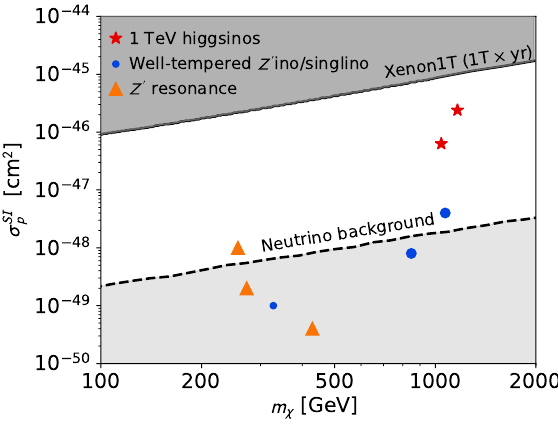
Figure 6. The position of the benchmark points in the ( m (cid:31) , (cid:27) SI 90% C.L. upper bound from the XENON-1T Collaboration [59]. Di(cid:11)erent point-styles mark the di(cid:11)erent types of neutralinos described in section